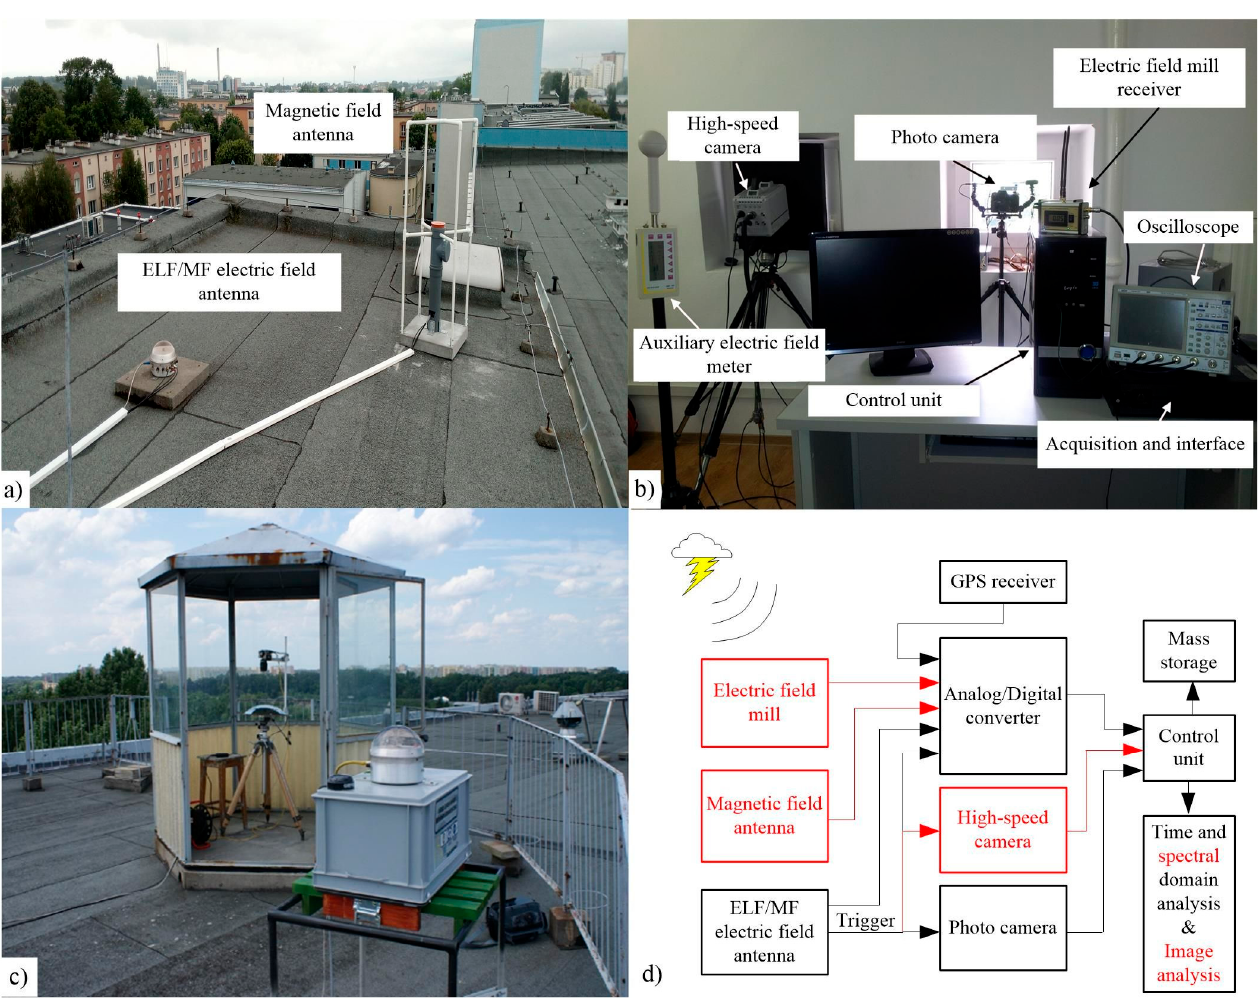
Figure 1. Lightning observatory sites in Rzeszow and Warsaw; sensors used for electromagnetic measurements in Rzeszow are shown in panel ( a ), and the supplementary video acquisition portion is provided in panel ( b ), while the general view of the LLDN-F station located on the roof of IG PAN building is presented in panel ( c ). Here, the GPS/Garmin receiver and E-field antenna sensor are mounted on the top of the grey box with the A/D recorder and the power supply buffer inside. The additional cabin used for optical lightning observations has the parabolic mirror inside and a digital fast camera mounted on a tripod. ( d ) Block diagram of lightning registration systems in Rzeszow and Warsaw. Notice that both systems are similar regarding their hardware configuration. Additional elements which were present in the system operating in Rzeszow were highlighted in red in the diagram.